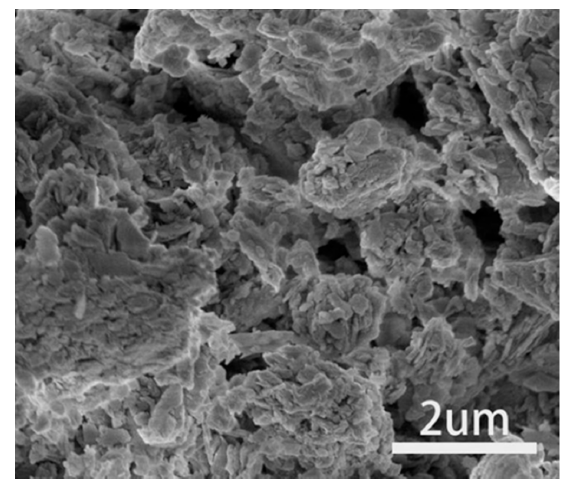
Figure 2. Scanning electron microscopy (SEM) image of natural zeolite. Table 1. Chemical composition of raw materials (wt.%).